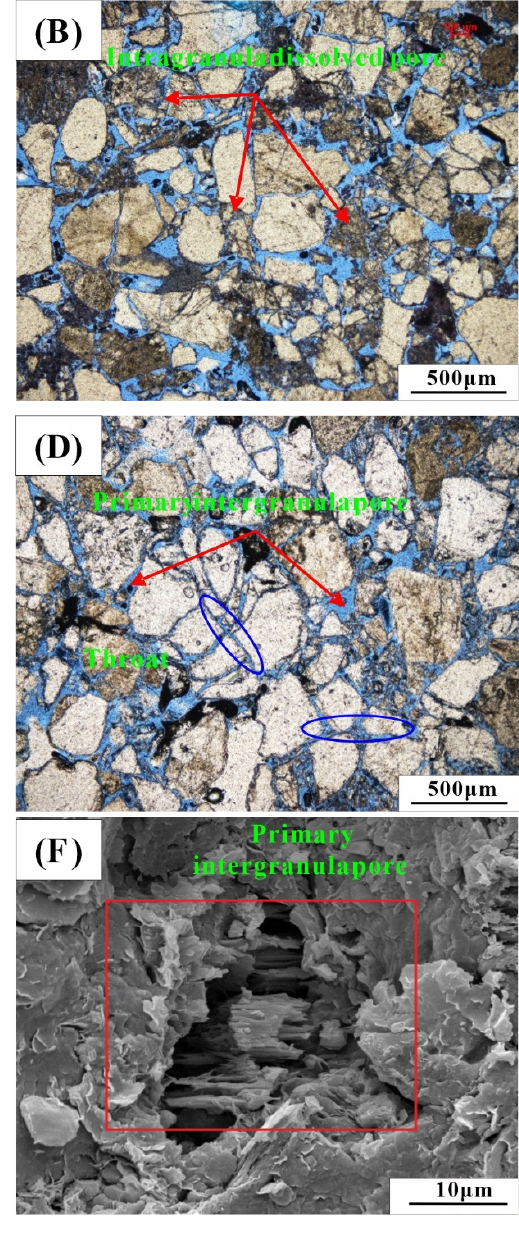
Figure 11. ( A ) The primary intergranular pores are the main ones, with a small amount of dissolu- tion pores, and the face ratio is 25%, PL19 − 3 − A well, L50, 1224.00 m. ( B ) There are two main types of neck-shaped and point-shaped throats, PL19 − 3 − A well, L70, 1319.50 m. ( C ) The point type throat PL19 − 9 − A well, L82, 1552.73 m. ( D ) The primary intergranular pores, PL19 − 9 − A well, L82, 1553.08 m; ( E ) The primary intergranular pores, PL19 − 9 − A well, L82, 1553.08 m. ( F ) The primary intergran- ular pores, PL19 − 9 − A well, L50, 1379.61 m.